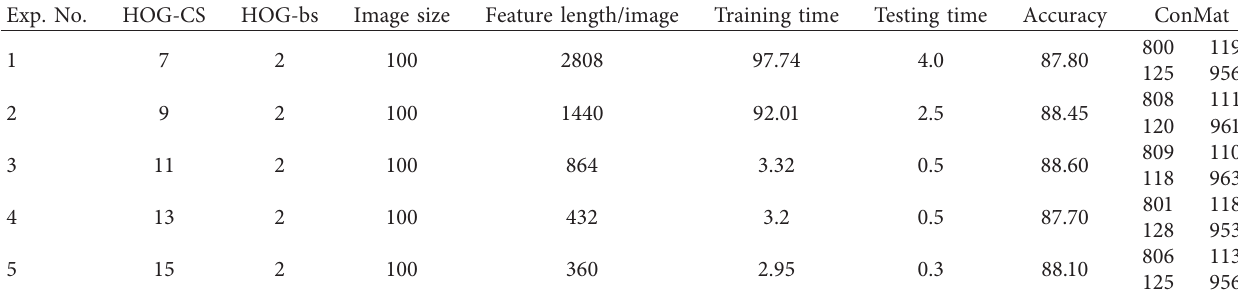
Table 3: HOG and SVM optimized parameters for training and testing with the SMO. Exp.